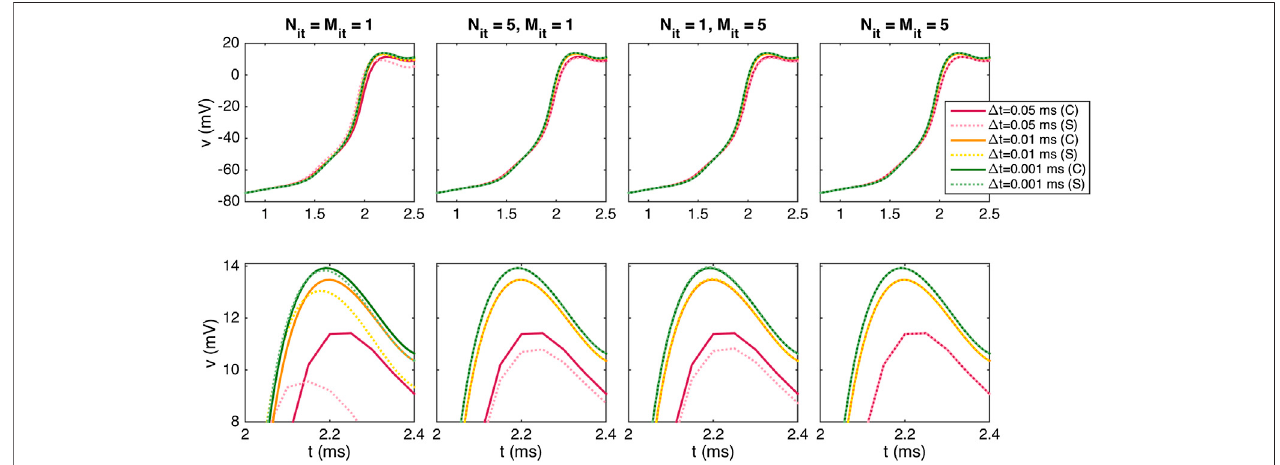
FIGURE 11 | Comparison of v at the center of the membrane of the center cell as a function of time computed using the coupled and splitting approaches for different combinations of the time step, Δ t , number of outer iterations, N it , and number of inner iterations, M it . The upper panel shows the full upstroke of the action potential, and the lower panel focuses on the action potential peak. The parameters used in the simulations are speci fi ed in Tables 1 and 3 .